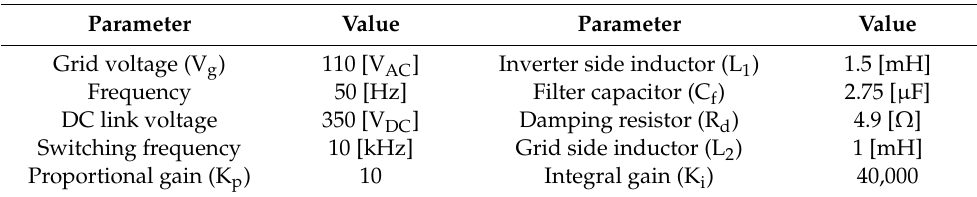
Table 2. GCI system and controller parameters.